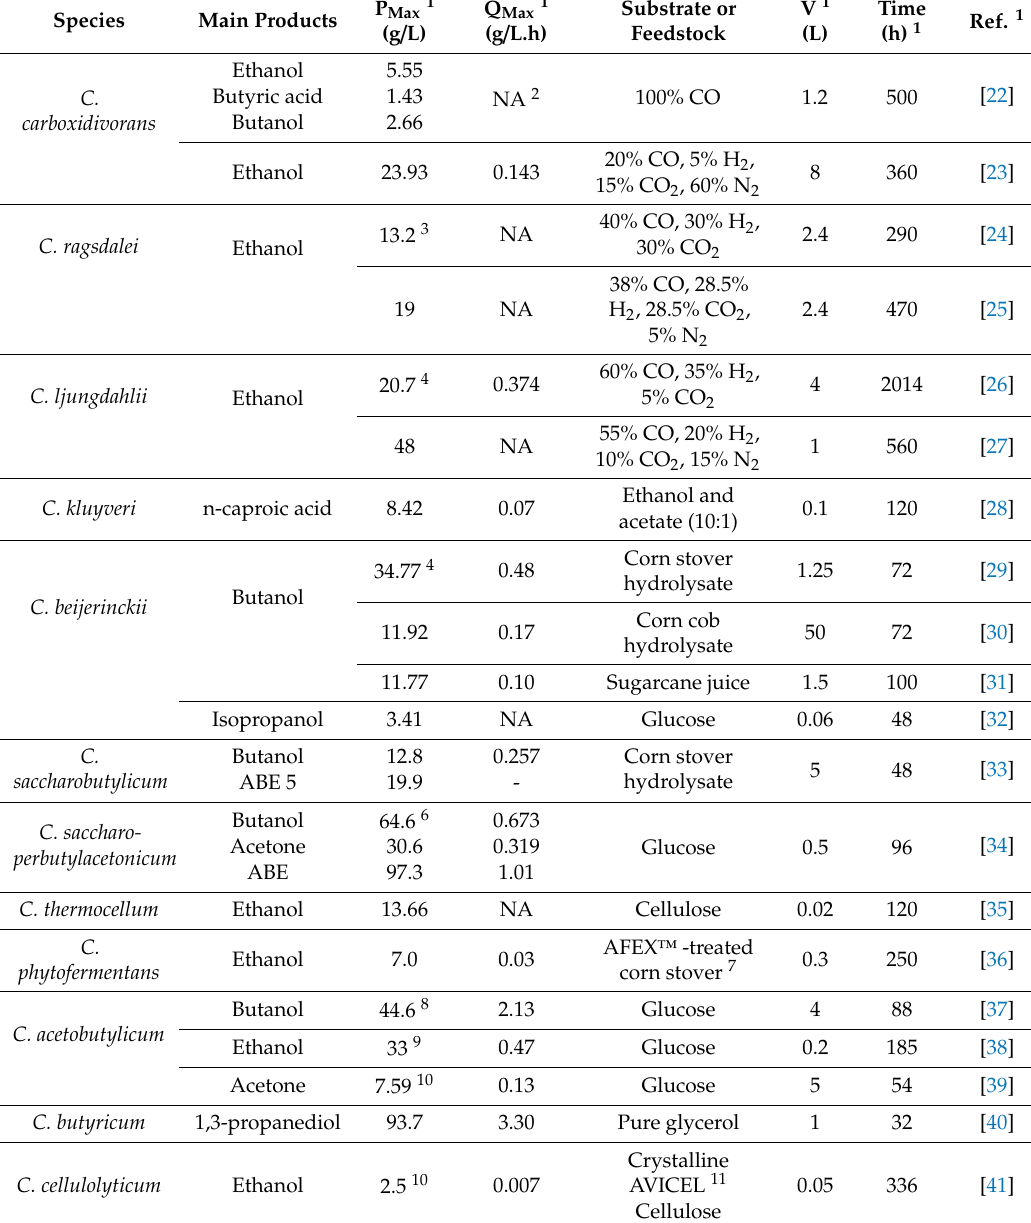
Table 1. Main products and production data for Clostridium species of interest to